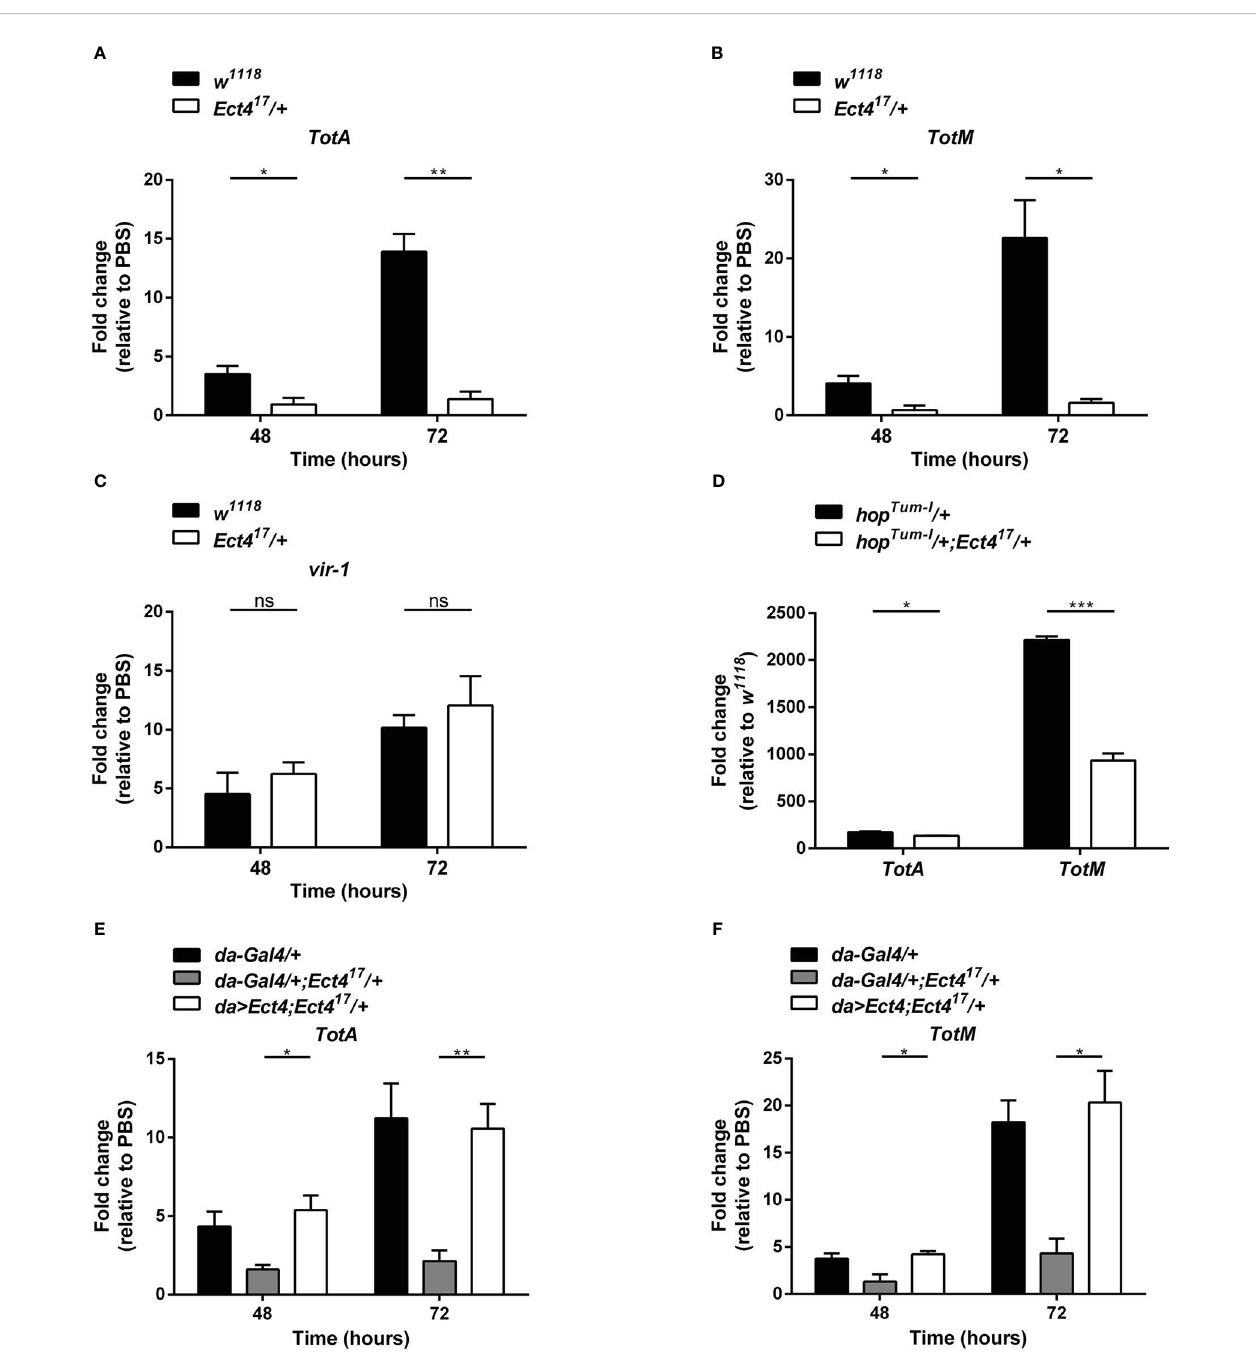
FIGURE 4 Ect4 is required for TotA and TotM induction in response to DCV infection. (A – C) Expression of JAK/STAT-dependent gene TotA , TotM , and vir-1 at 48 and 72 h after DCV infection determined by RT-qPCR in whole fl ies. Expression of the gene of interest was normalized to transcript levels of the housekeeping gene Rpl32 and expressed as fold change relative to mock infection (PBS). (D) Expression levels of TotA and TotM on 3-5 d-old unchallenged fl ies carrying one copy of hop Tum-l allele with or without the Ect4 mutant allele. Expression of TotA and TotM was normalized to transcript levels of the housekeeping gene Rpl32 and expressed as fold change relative to wild-type ( w 1118 ) fl ies. (E, F) Expression levels of TotA and TotM at 48 and 72 h in control fl ies or Ect4 mutant fl ies overexpressing Ect4 transgene under a ubiquitous da-Gal4 driver upon DCV infection. Data represent the means ± standard errors of 3 independent pools of 10 male fl ies (A – F) for each genotype. T- test (A – F) : * P < 0.05, ** P < 0.01, *** P < 0.001, ns, not signi fi